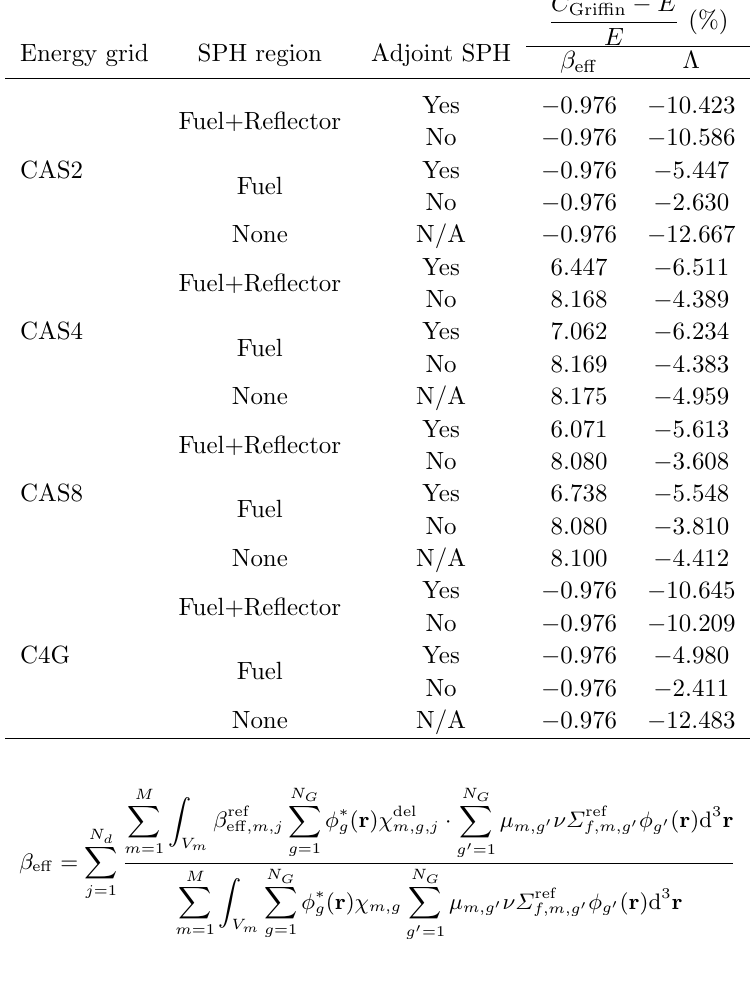
Table 10. Relative differences between Griffin and benchmark kinetics